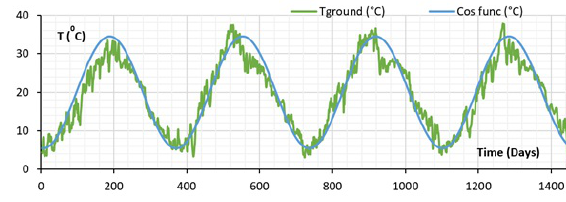
Fig. 2. Earth temperature obtained from RETscreen (daily) and the approximate cosine function